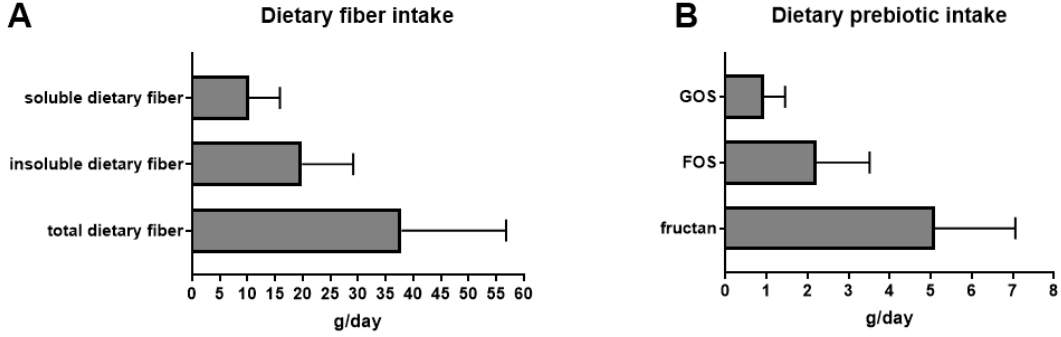
Figure 1. Mean daily intakes of dietary fiber ( A ) and prebiotic ( B ) calculated from the FiberTAG Food Frequency Questionnaire submitted to healthy volunteers using the FiberTAG repertoire. Values are means ± SD of the median values of daily fiber intake obtained for each volunteer and each fiber type.